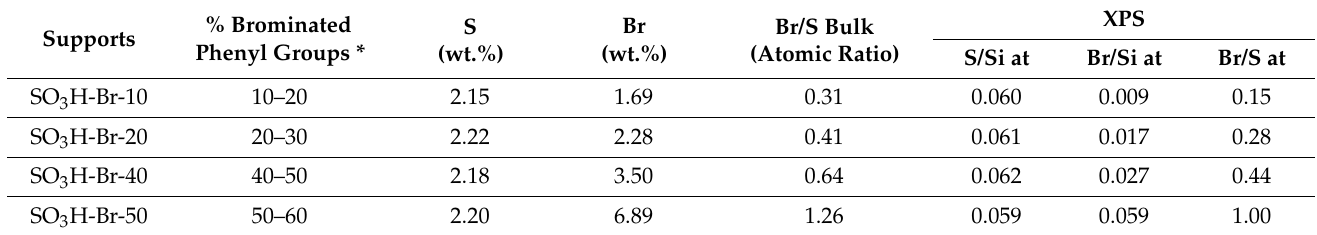
Table 1. Specifications, chemical composition determined by Total reflection X-ray fluorescence (TXRF), and surface atomic ratios of the support determined from X-ray photoelectron spectra (XPS) of silica supports.